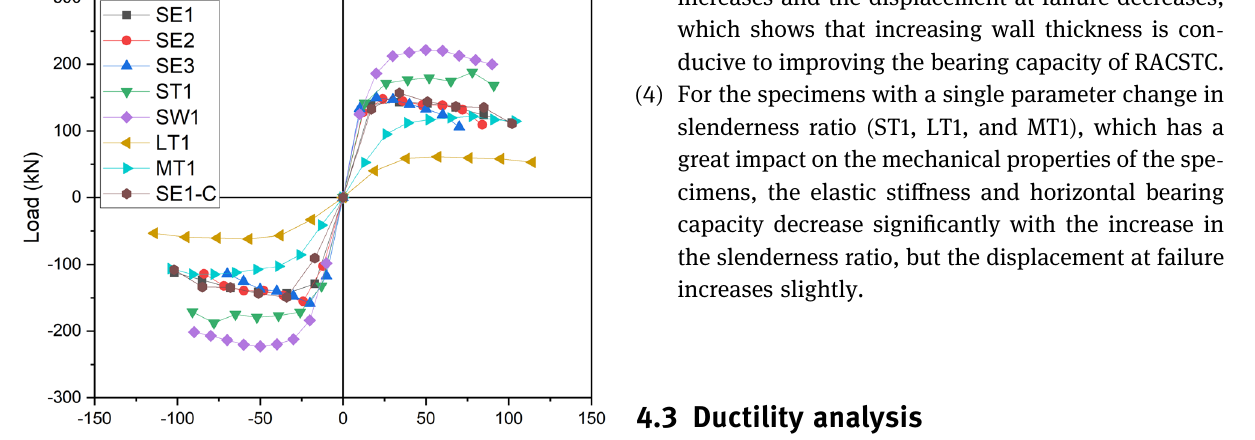
( 3 ) For the specimens SE1, ST1, and SW1 with a single parameter change in wall thickness, the elastic sti ff - ness increases slightly with the increase in wall thick - ness. The horizontal bearing capacity of the specimen